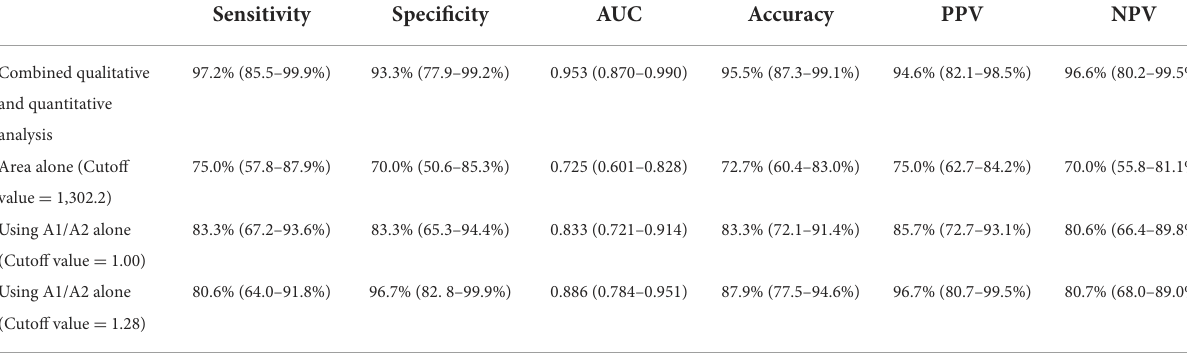
TABLE 5 Comparison of diagnostic performance in differentiating malignant tumor from benign tumor. Sensitivity